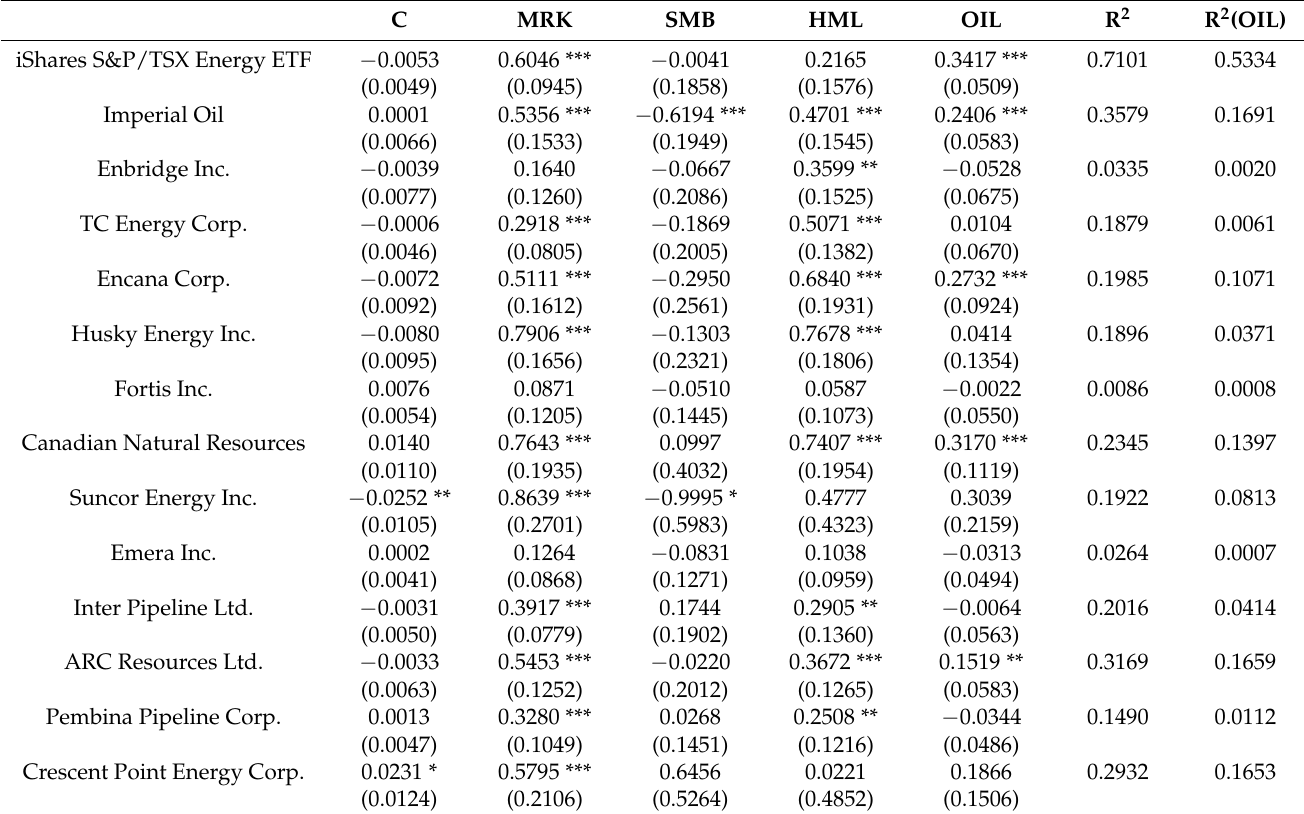
Table 6. Regression results for the 2000–2008